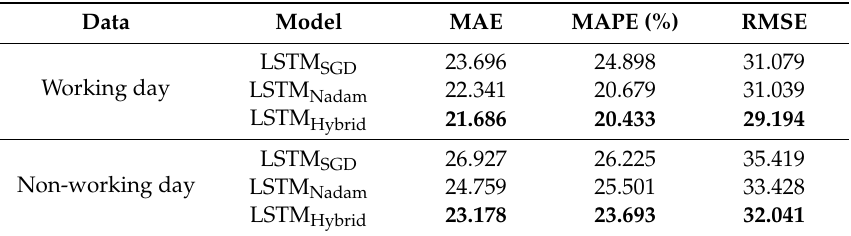
Table 7. Comparison results of working days and non-working